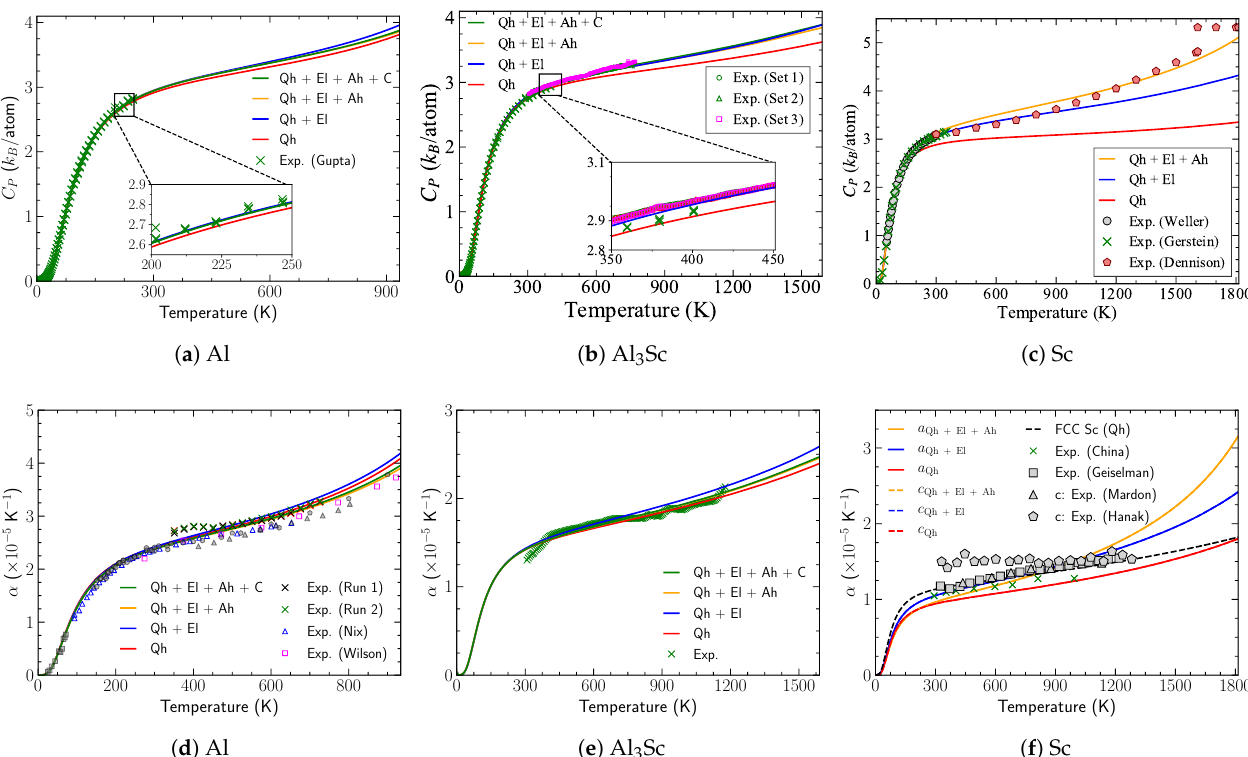
Figure 1. Calculated and measured ( a )–( c ) isobaric heat capacity and ( d )–( f ) coefficient of thermal expansion of fcc Al, L 1 2 Al 3 Sc and hcp Sc including quasiharmonic (Qh), electronic (El), and anharmonic (Ah) excitations as well as el-ph coupling ( c ). In addition, the coefficient of thermal expansion of Sc in the fcc phase is given in ( f ). The literature values of CTE (blue triangles, magenta squares, and all gray symbols) for Al in ( d ) are taken from Refs. [64], [65] and [66]. Experimental calorimetric data are included as green crosses [27] in ( a ) and ( b ). Sc thermal expansion data are included as triangles [67], pentagons [68], hexagons [69]. The measured data for Sc heat capacity are included as crosses [70], pentagons [71], and circles [72]. The figures have been adapted from [43].